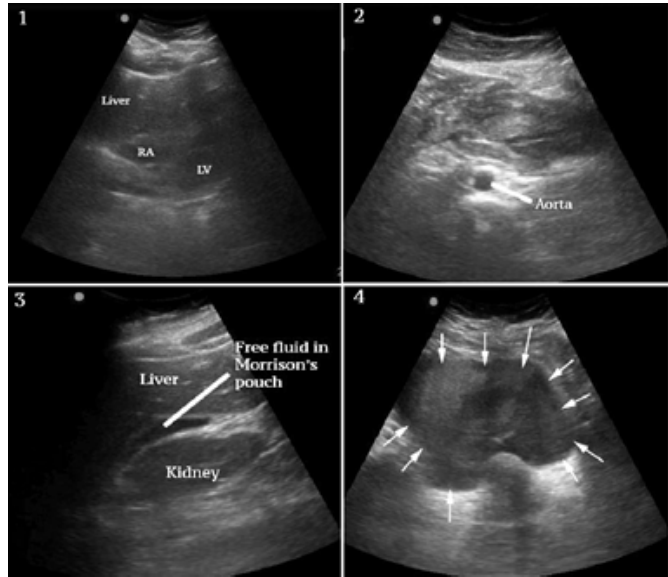
Figure 1. Frame 1 shows a subxiphoid view of the heart without pericardial effusion or RV dilation. Additonally, left ventricle (LV) function was vigorous. RA-right atrium. Frame 2 shows a portion of the abdominal aorta with a normal diameter. Frame 3 shows free fluid in Morison’s pouch. Frame 4 shows fluid with mixed and increased echogenicity in the pelvis consistent with blood (arrows).